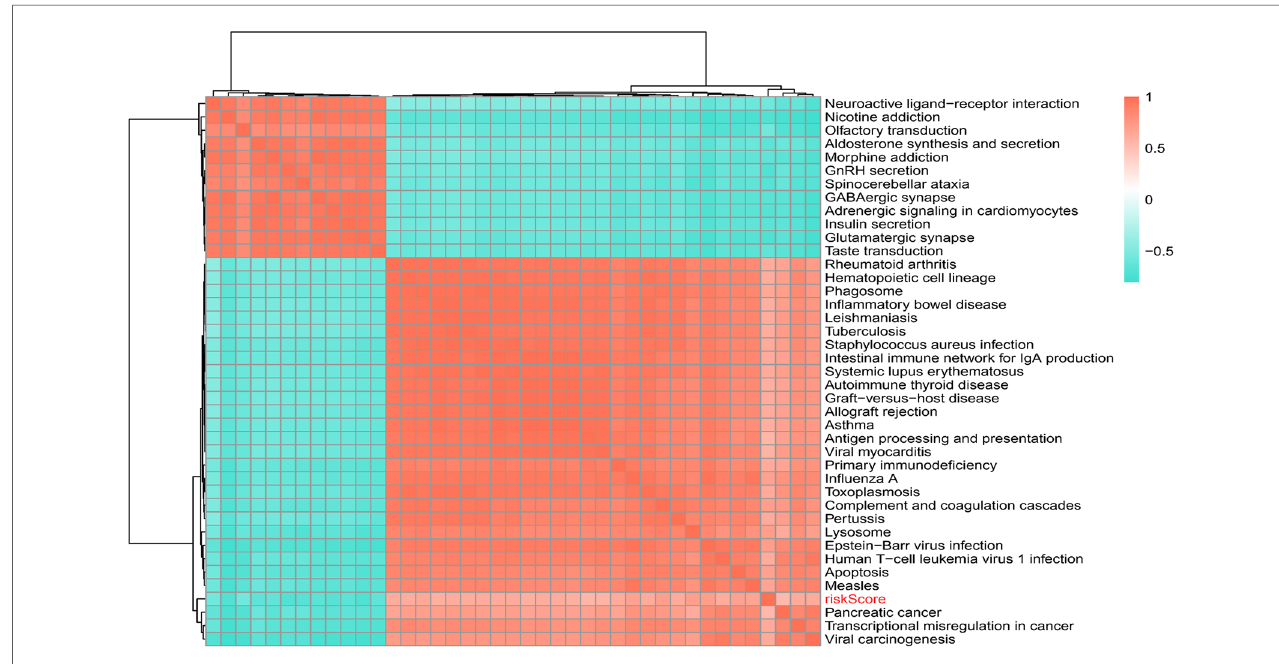
FIGURE 8 Correlation of risk scores with KEGG pathway.